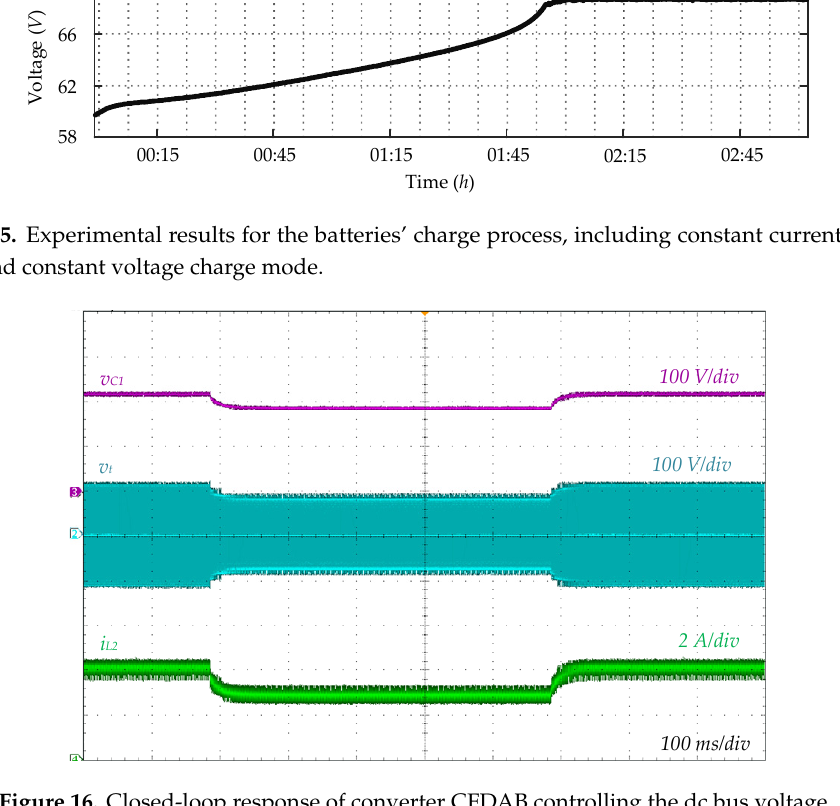
Figure 16. Closed-loop response of converter CFDAB controlling the dc bus voltage.